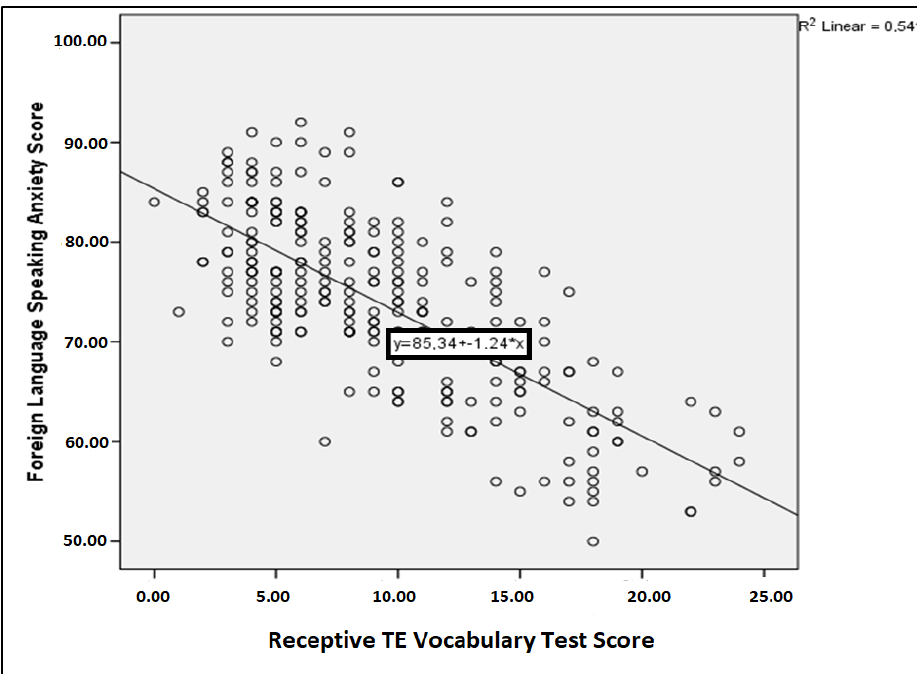
Figure 2. Scatterplot of linearity and the regression equation.